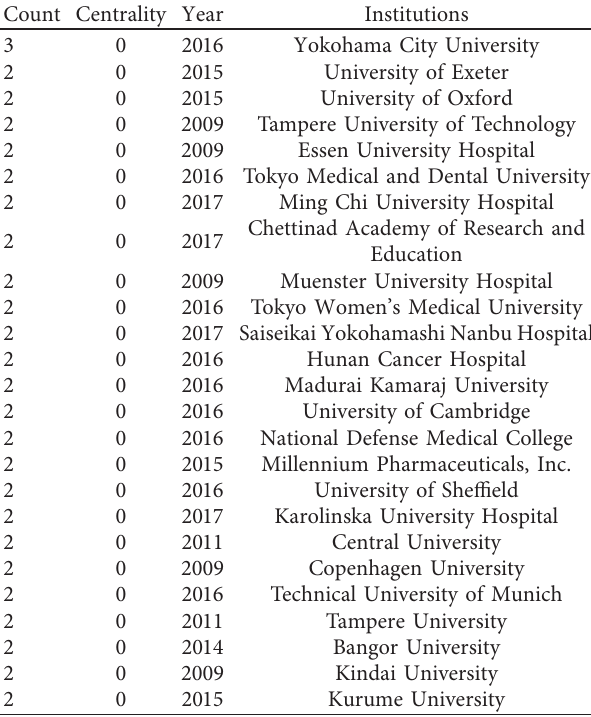
Table 5: The list of